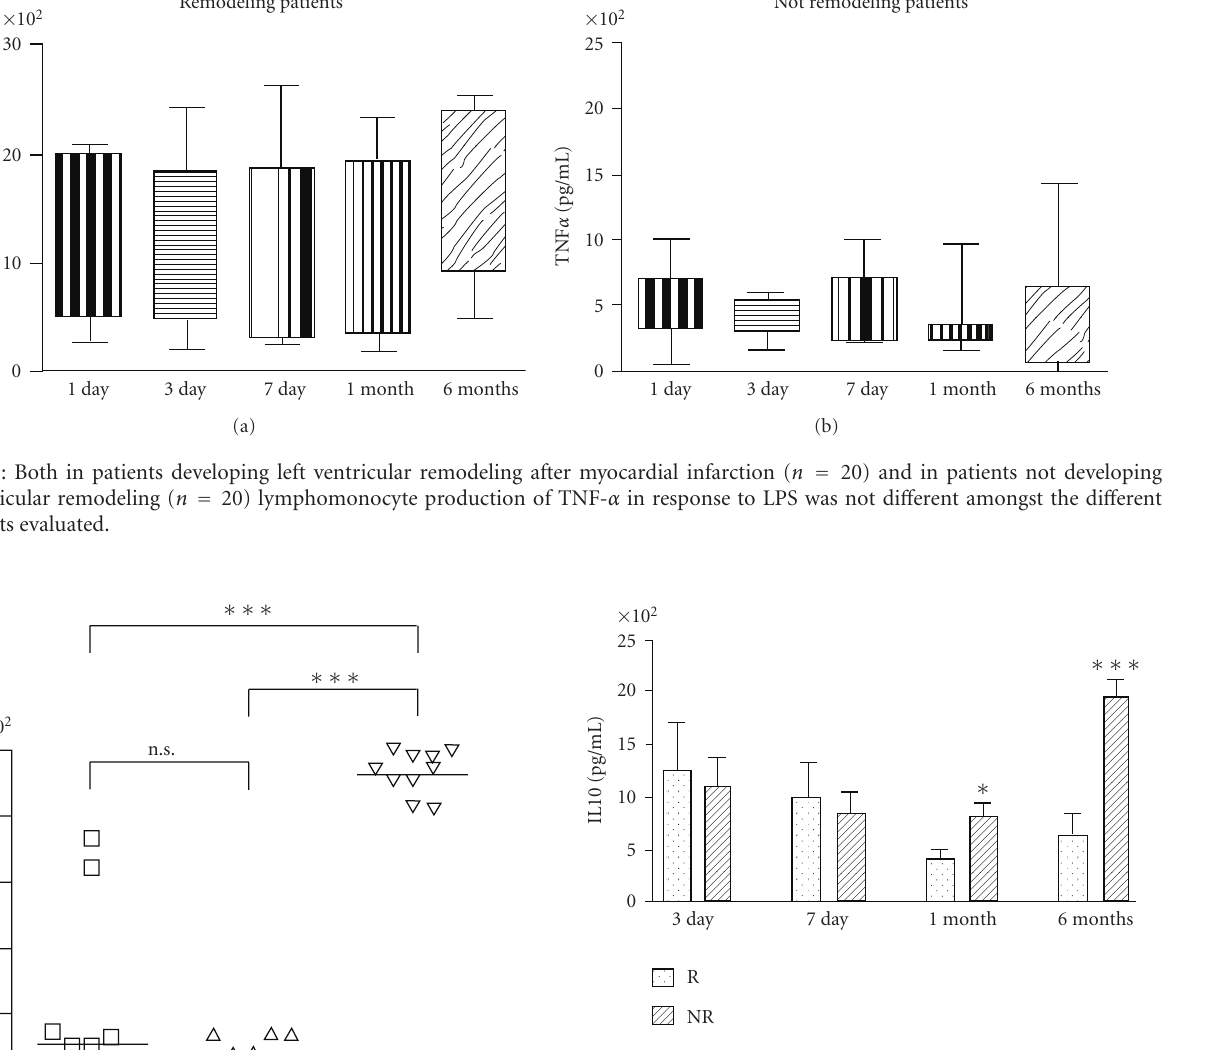
Figure 5: In patients developing left ventricular remodeling after myocardial infarction (R, n = 20) lymphomonocyte production of IL10 in response to LPS was reduced in comparison with patients not developing left ventricular remodeling (NR, n = 20) 1 month and 6 months after reperfusion ( ∗ P < . 05 and ∗∗∗ P < . 001,